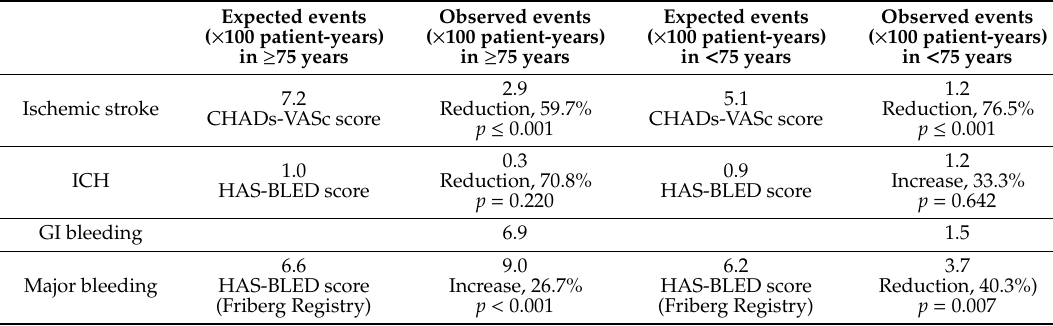
Table 3. Overall event outcomes in patients aged < 75 and ≥ 75 years.